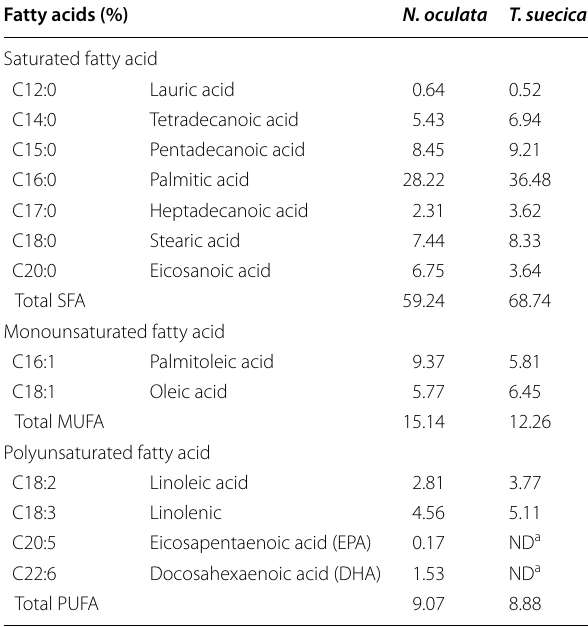
Table 2 Fatty acids profile of N. oculata and T. suecica cultured in